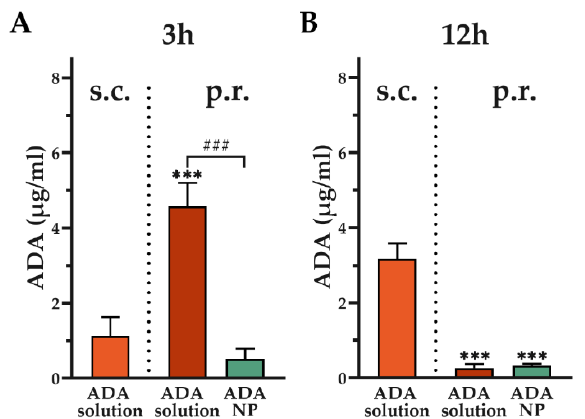
Figure 10. Adalimumab (ADA) concentration in serum from colitis mice ( A ) 3 and ( B ) 12 h after final administration. Colitis was induced by rectal administration of TNBS (90 mg/kg body weight) and the mice were treated with ADA coupled nanoparticles with 100% surface loading rate (ADA- NP, p.r.) or ADA solution (ADA, s.c. or p.r.) for 3 consecutive days. Blood samples were taken 3